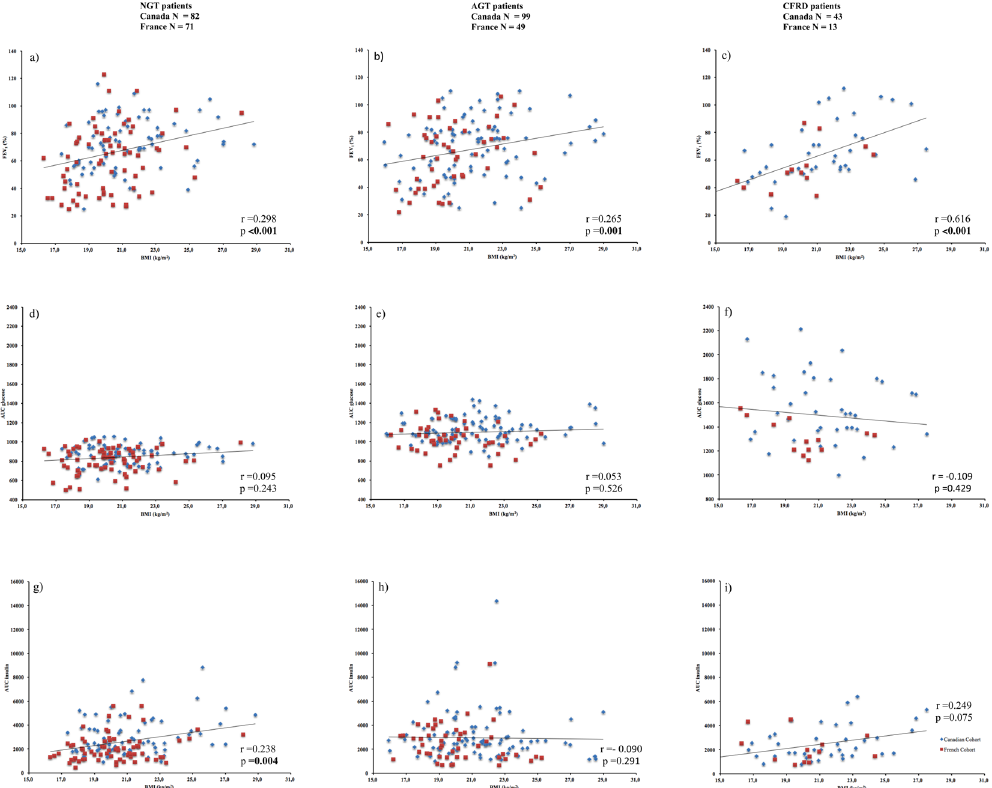
Figure 2. Spearman’s correlation for ( a ) BMI and FEV1in NGT patients ( b ) BMI and FEV1 in AGT patients and ( c ) BMI and FEV1 in CFRD patients ( d ) BMI and AUC glucose in NGT patients ( e ) BMI and AUC glucose in AGT patients ( f ) BMI and AUC glucose in CFRD patients ( g ) BMI and AUC insulin in NGT patients ( h ) BMI and AUC insulin in AGT patients ( i ) BMI and AUC insulin in CFRD patients. Blue diamond: Canadian cohort and Red square: French cohort.